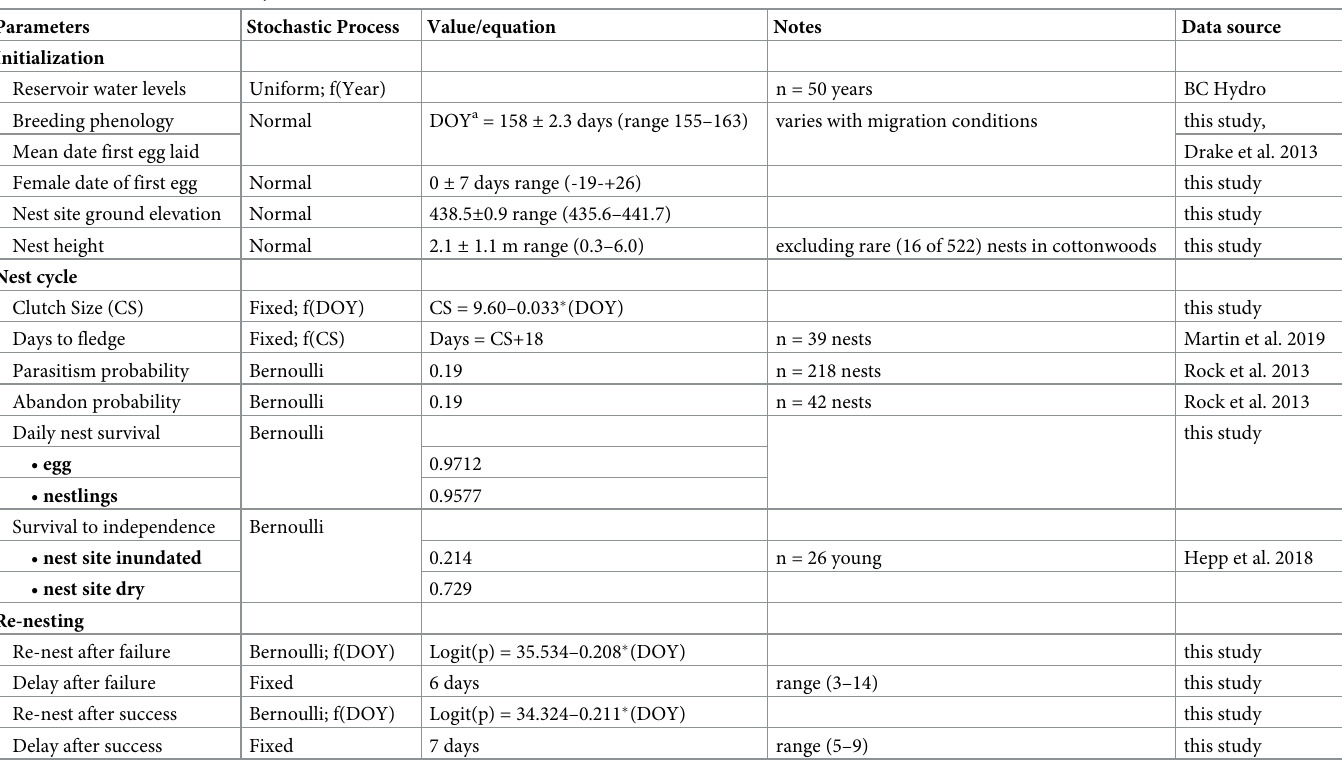
Table 1. Parameters used in the yellow warbler individual-based